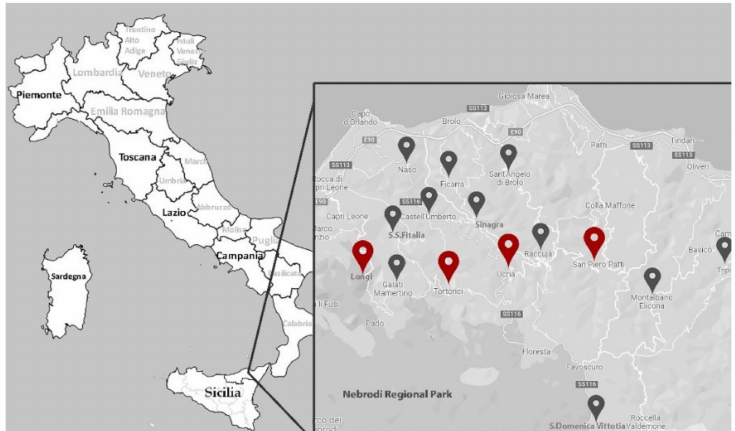
Figure 6. Location sites of hazelnut orchards where LPGB accessions (black pointer) were sampled and of private germplasm collection fields (red